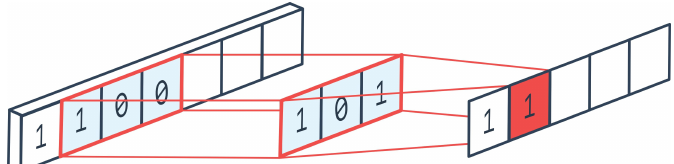
Figure 1. One-dimensional convolutional process. Input data is located on the ( left ), the filter in the middle, and the convolution output on the ( right